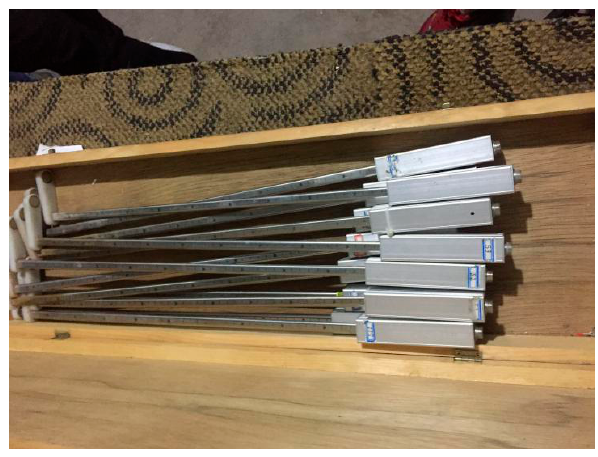
Figure 6. Water level collector.